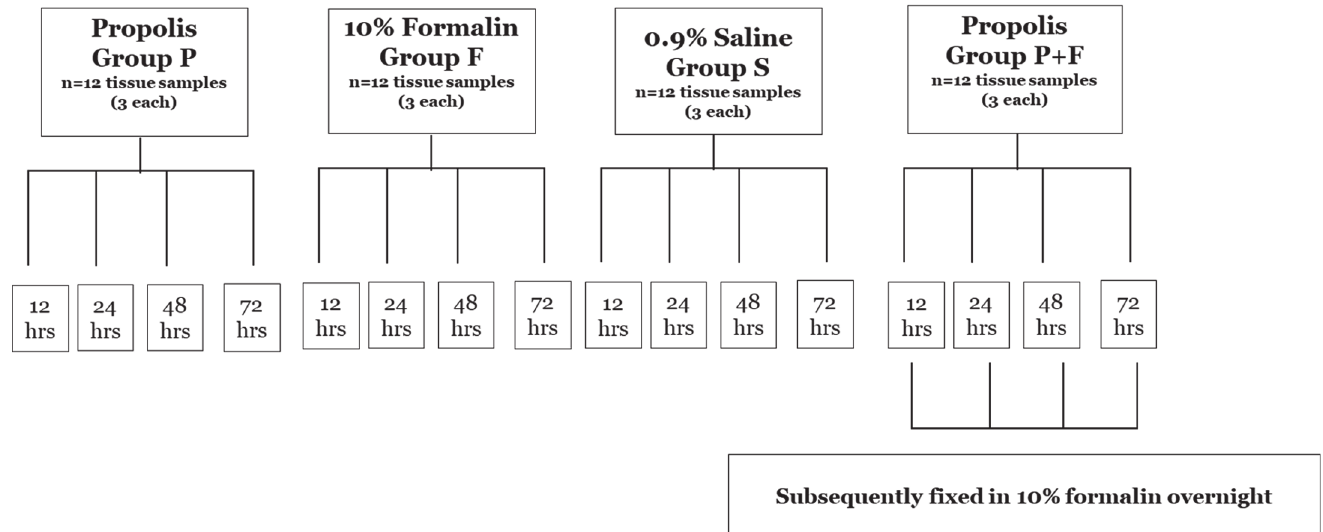
Figure 2. Flowchart of the specimen